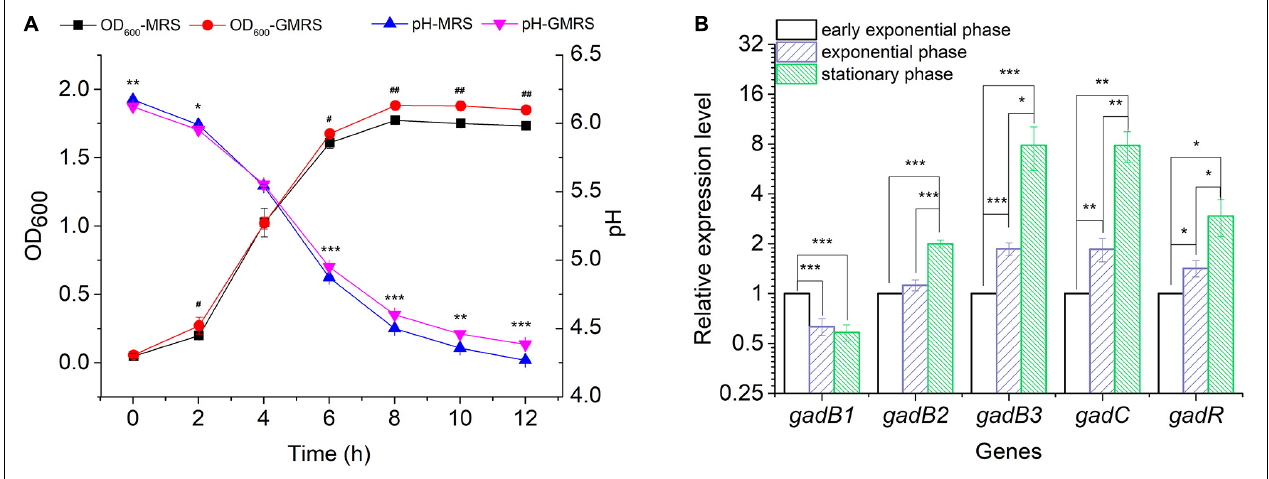
FIGURE 2 | Transcription of the gadB1 , gadB2 , gadB3 , gadC , and gadR . (A) Cell growth curves and pH curves of E. avium SDMCC050406 cultivated in MRS or GMRS. Well number represented the statistical significance of OD 600 . Asterisk represented the statistical significance of pH. (B) Relative expression levels of gadB1 , gadB2 , gadB3 , gadC , and gadR in different growth phases. Cells were cultured in GMRS and harvested at early exponential growth phase (2 h), exponential growth phase (4 h), and stationary phase (8 h). The relative expression levels of each gene at early exponential phase were set as 1.0. The relative expression level data were log 2 transformed. Data were reported as the mean ± SD of the results from three independent experiments. * p -value < 0.05, ** p -value < 0.01, *** p -value < 0.001, # p -value < 0.05, and ## p -value < 0.01.